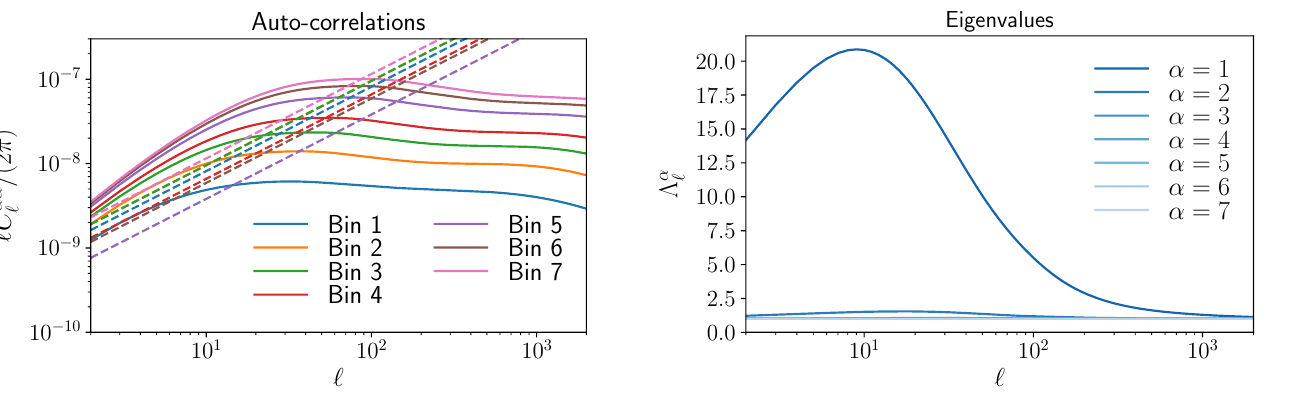
Figure 8. We show the angular power spectra C αα N αα for each redshift bin auto-correlation as a function of the (cid:96) multipole (cid:96) .